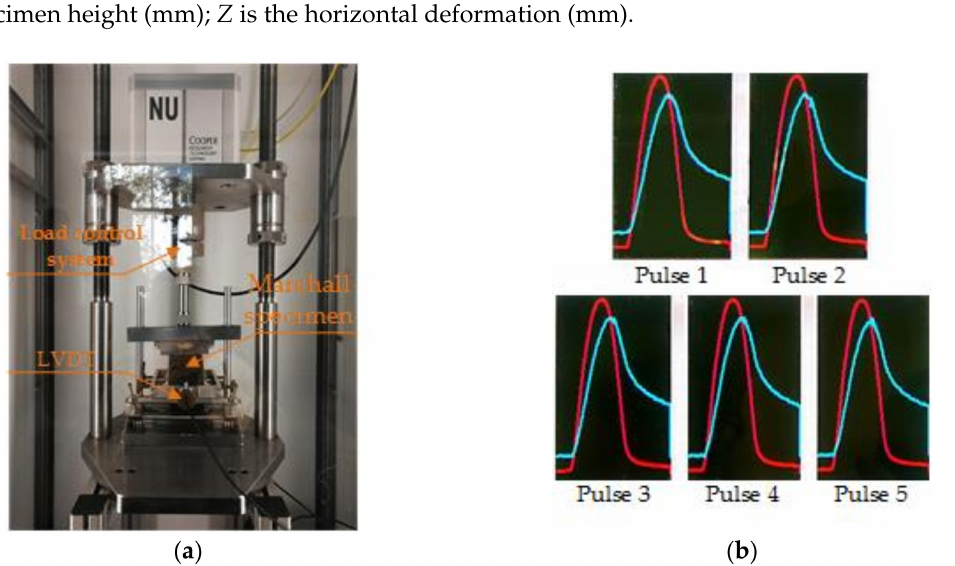
Figure 5. Indirect tensile stiffness modulus test: ( a ) indirect tensile stiffness modulus (ITSM) test; and ( b ) schematic diagram of the